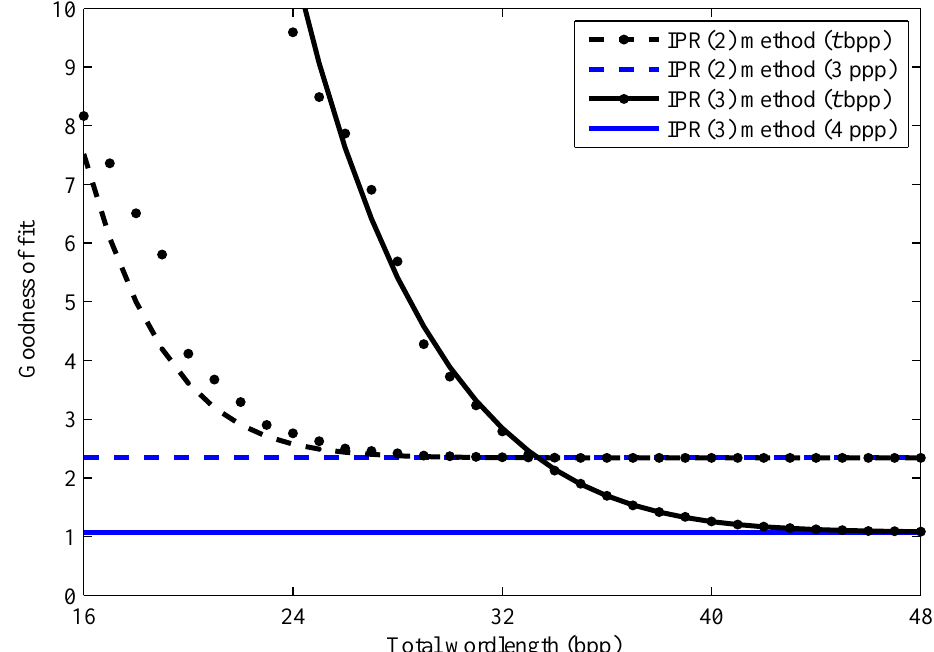
Figure 6. Fixed and floating-point implementations. For the fixed-point FPN calibration, actual (dots) and modeled (curved lines) goodness results are shown. Both are computed, at each total wordlength t , after optimization of the model. The floating-point FPN calibration results (horizontal lines) are the limiting values. Here, bpp stands for bits per